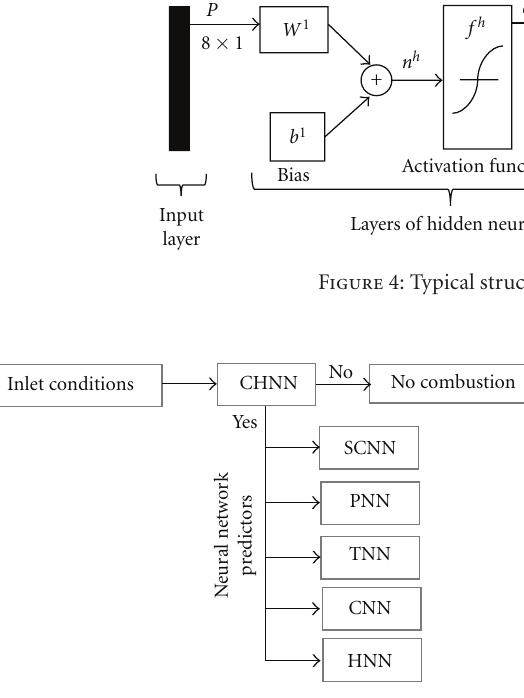
Figure 5: First approach of modeling (when combustion occurs for a set of inlet conditions).